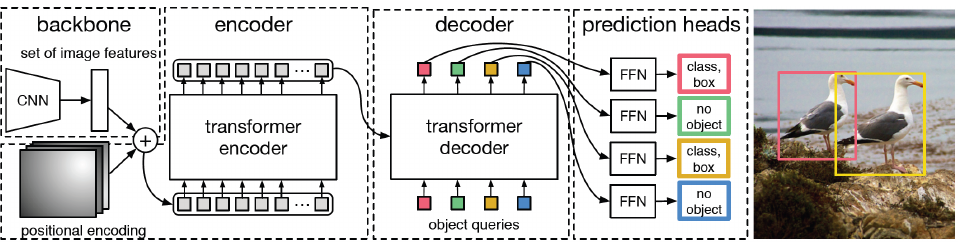
Figure 1. DETR architecture [20].